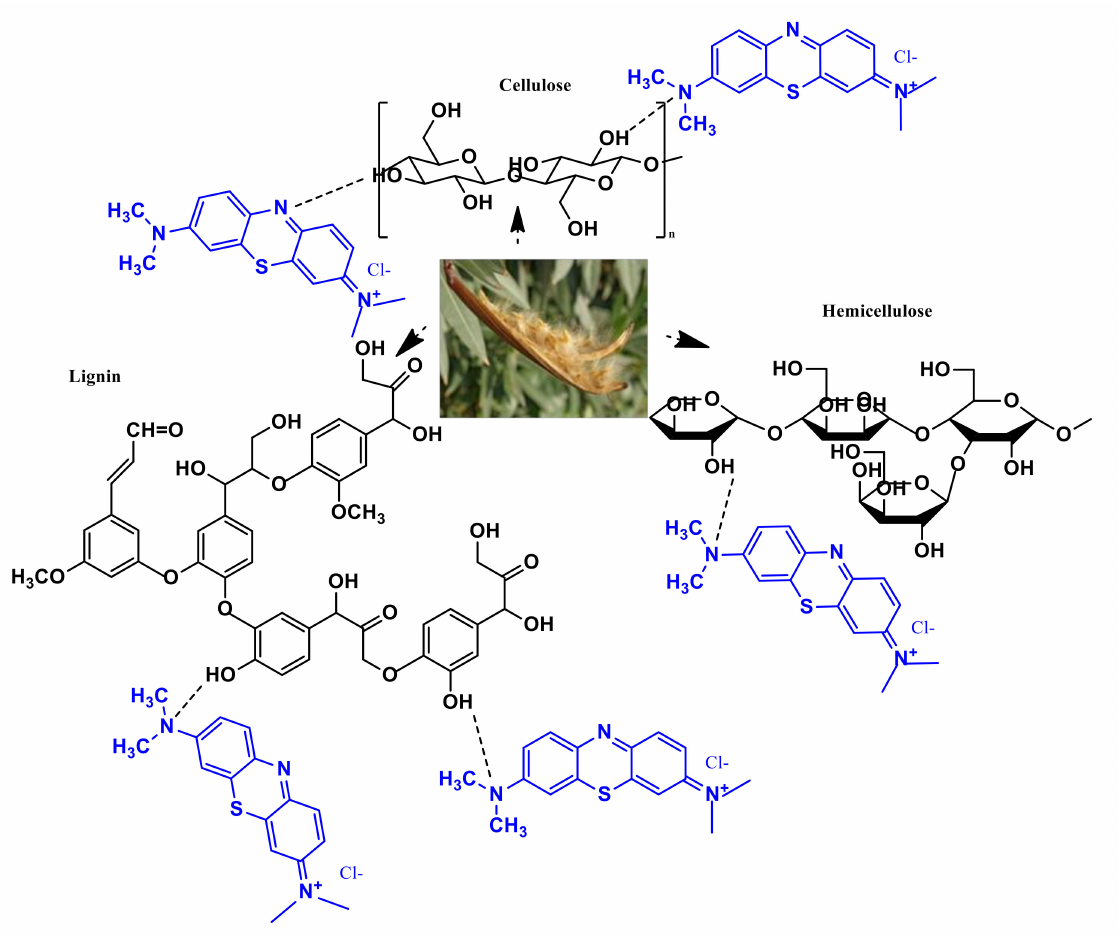
Figure 2. FTIR spectrum of Nerium oleander